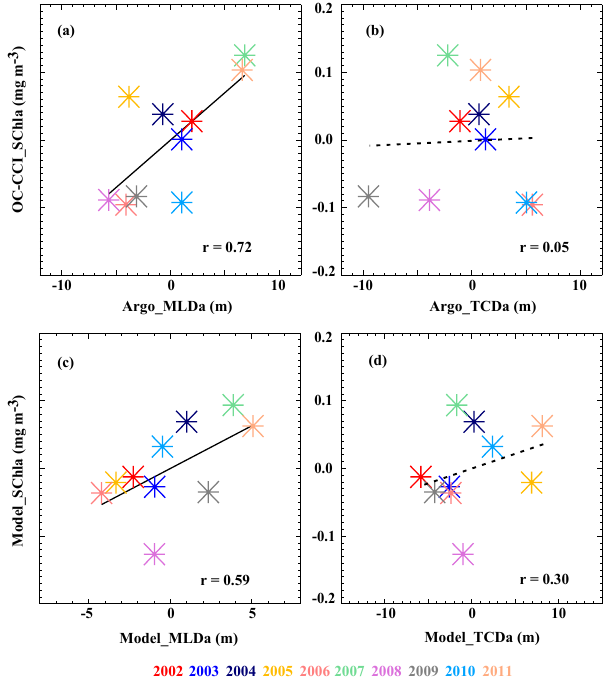
Figure 9. Scatter plot of winter NAS-averaged OC-CCI SChl anomalies against observed (a) MLD and (b) TCD anomalies over the 2002–2011 period. (c–d) Idem for model. Plain (dashed) lines indicate the linear regression that is (not) significantly different from zero at the 90% confidence